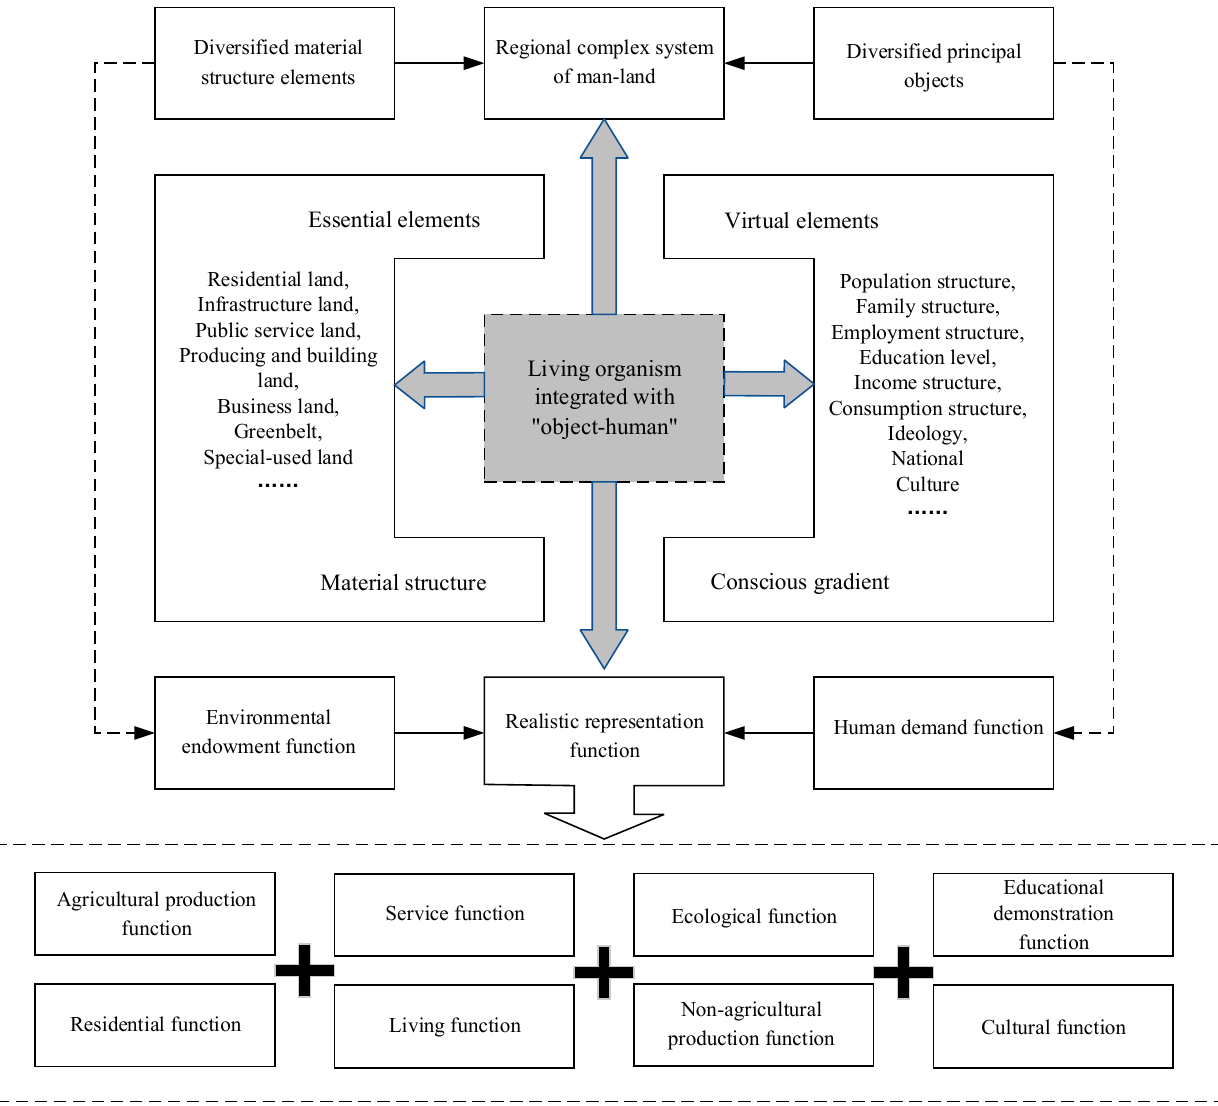
Figure 1. Frame diagram of the human-land-relationship system of rural residential land.